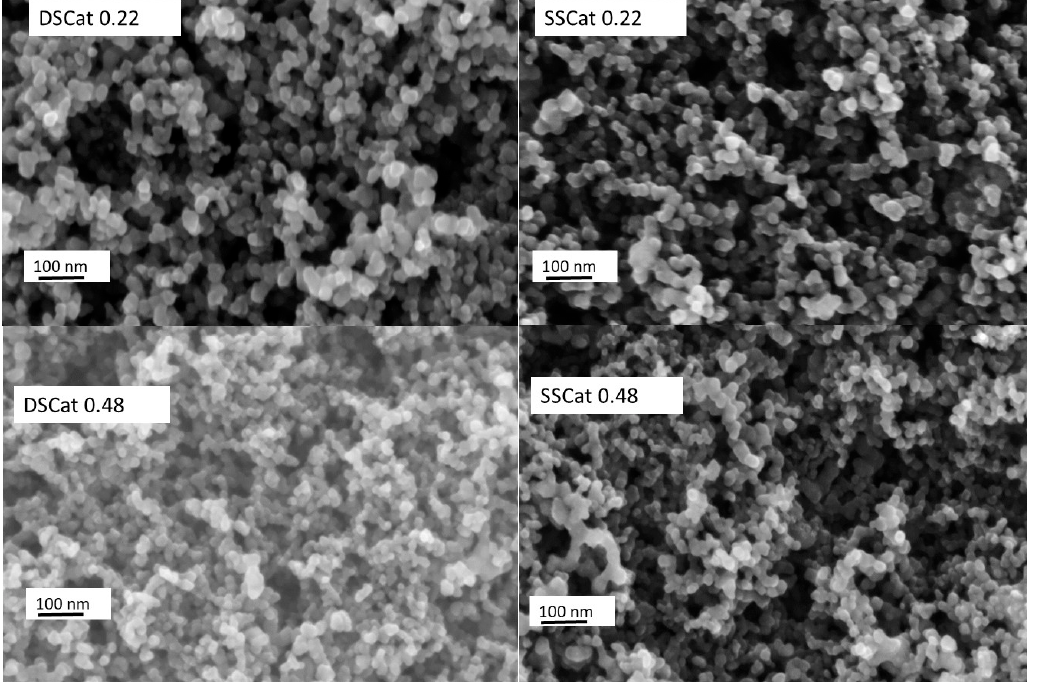
Figure 2. Scanning electron micrographs recorded for DSCat 0.22 and DSCat-0.48 catalysts.